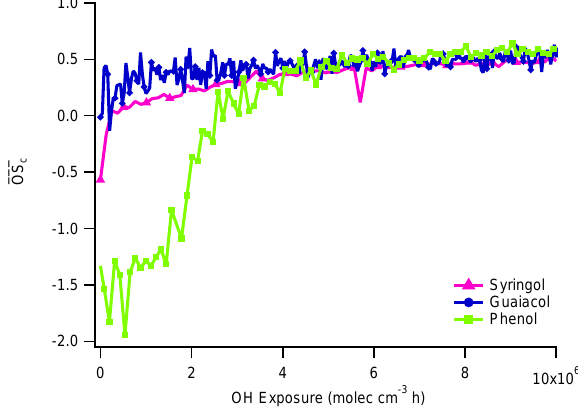
Fig. 10. Evolution of the average carbon oxidation state (OS c ) for studied